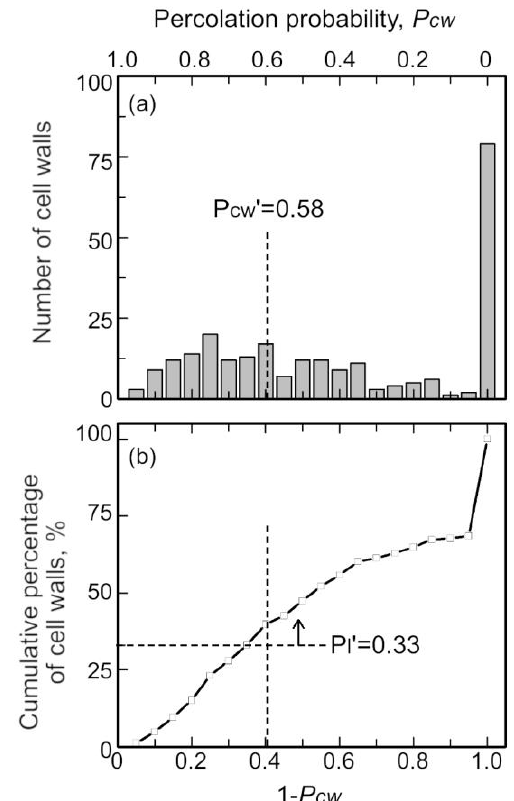
Figure 13. Distribution of cell walls. ( a ) Number of cell walls, and ( b ) cumulative percentage of cell walls plotted against the percolation probability P cw .